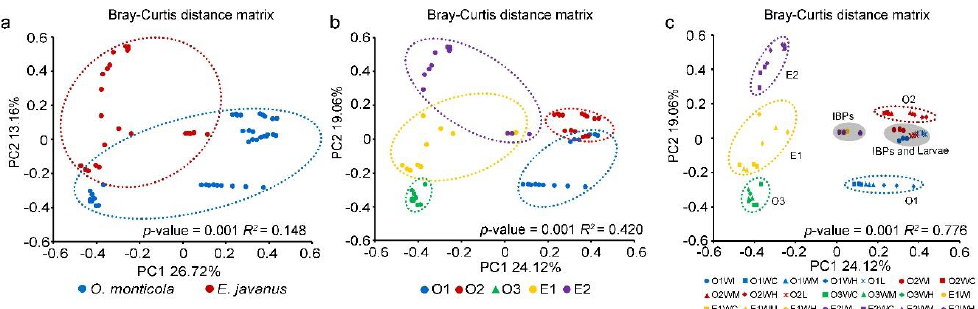
Figure 3. Principal coordinate analysis (PCoA) of bacterial community composition and abundance among different groups. ( a ) Bray – Curtis distance matrix for samples from O. monticola and E. javanus . ( b ) Bray – Curtis distance matrix for samples from different colonies of each ant species. ( c ) Bray – Curtis distance matrix for samples from infrabuccal pockets, gut sections (crops, midguts, and hindguts) of workers and larvae of O. monticola and E. javanus . Dots in different color represented different groups. PERMANOVA tests showed statistical analysis between groups. O1, O2, and O3, three colonies of O. monticola ; E1 and E2, two colonies of E. javanus . WI, the infrabuccal pockets of workers; WC, the crop of workers; WM, the midguts of workers; WH, the hindguts of workers; L, larvae. Sample names are listed in Table